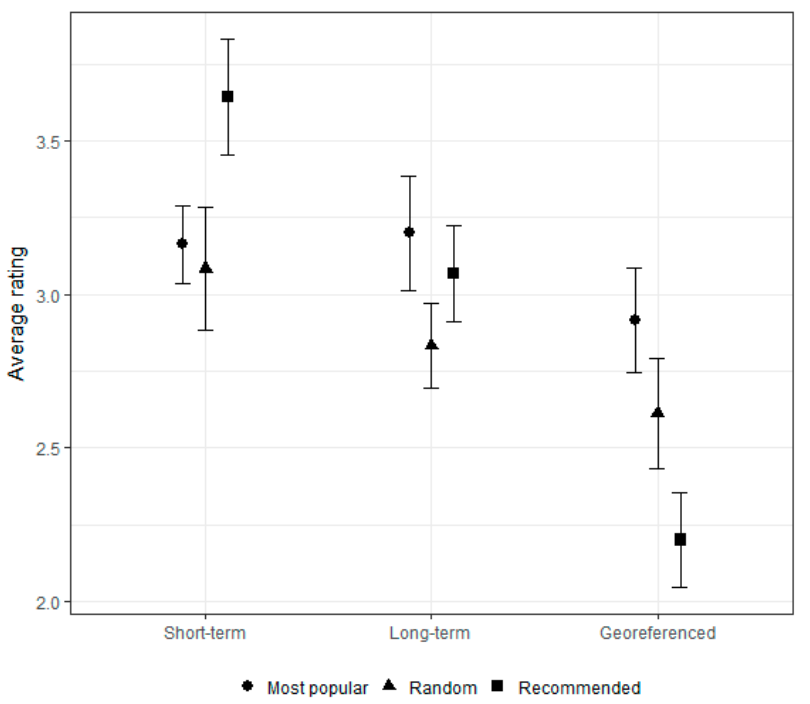
Figure5. Experiment2: Averageratinggiventoitemsfromthedi ff erentrecommendationmethodologies Figure 5 . Experiment 2: Average rating given to items from the different recommendation related to the list selected in the first evaluation methodologies related to the list selected in the first evaluation experiment.